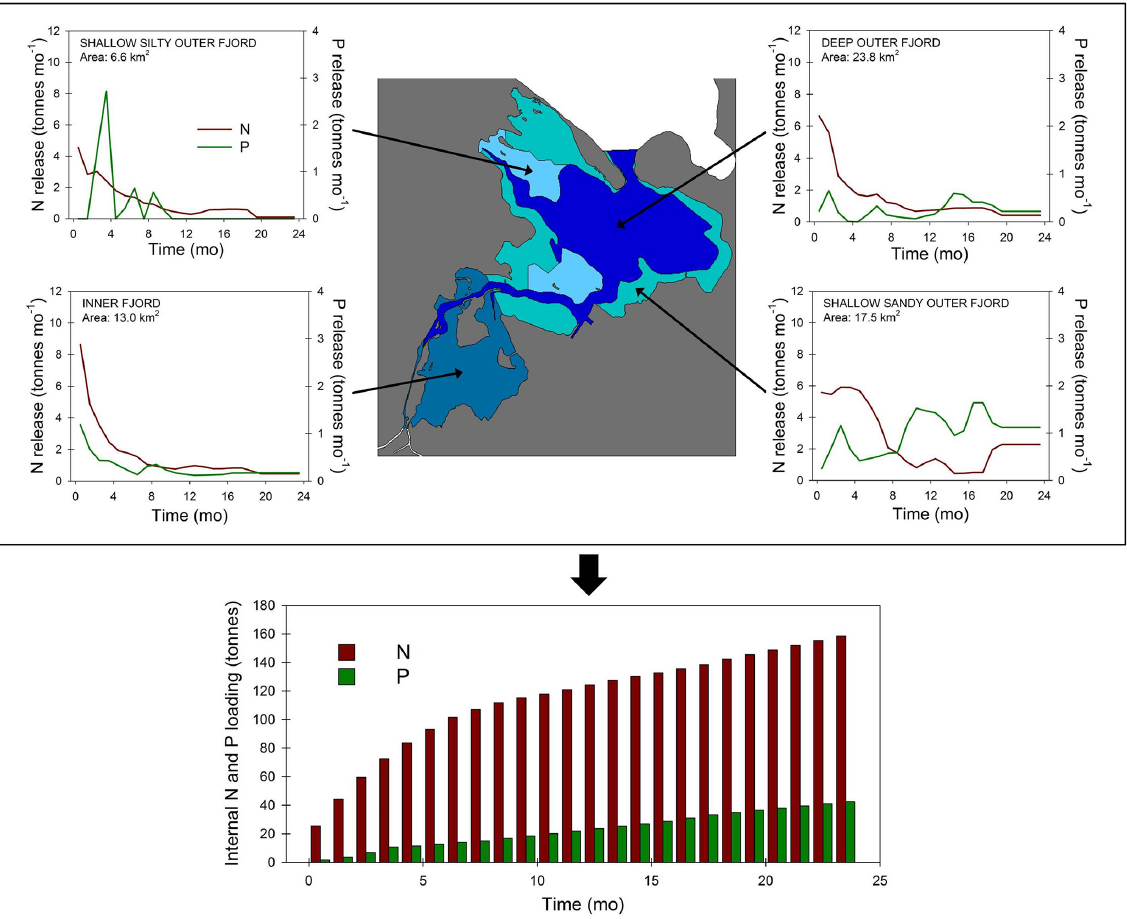
Figure 6. Estimated internal nutrient loading in Odense Fjord. The upper figure shows a schematic overview of Odense Fjord with the distribution of sediment types included in this study and their nutrient release over a 24-month period. The lower figure shows the cumulated nutrient release from the entire fjord